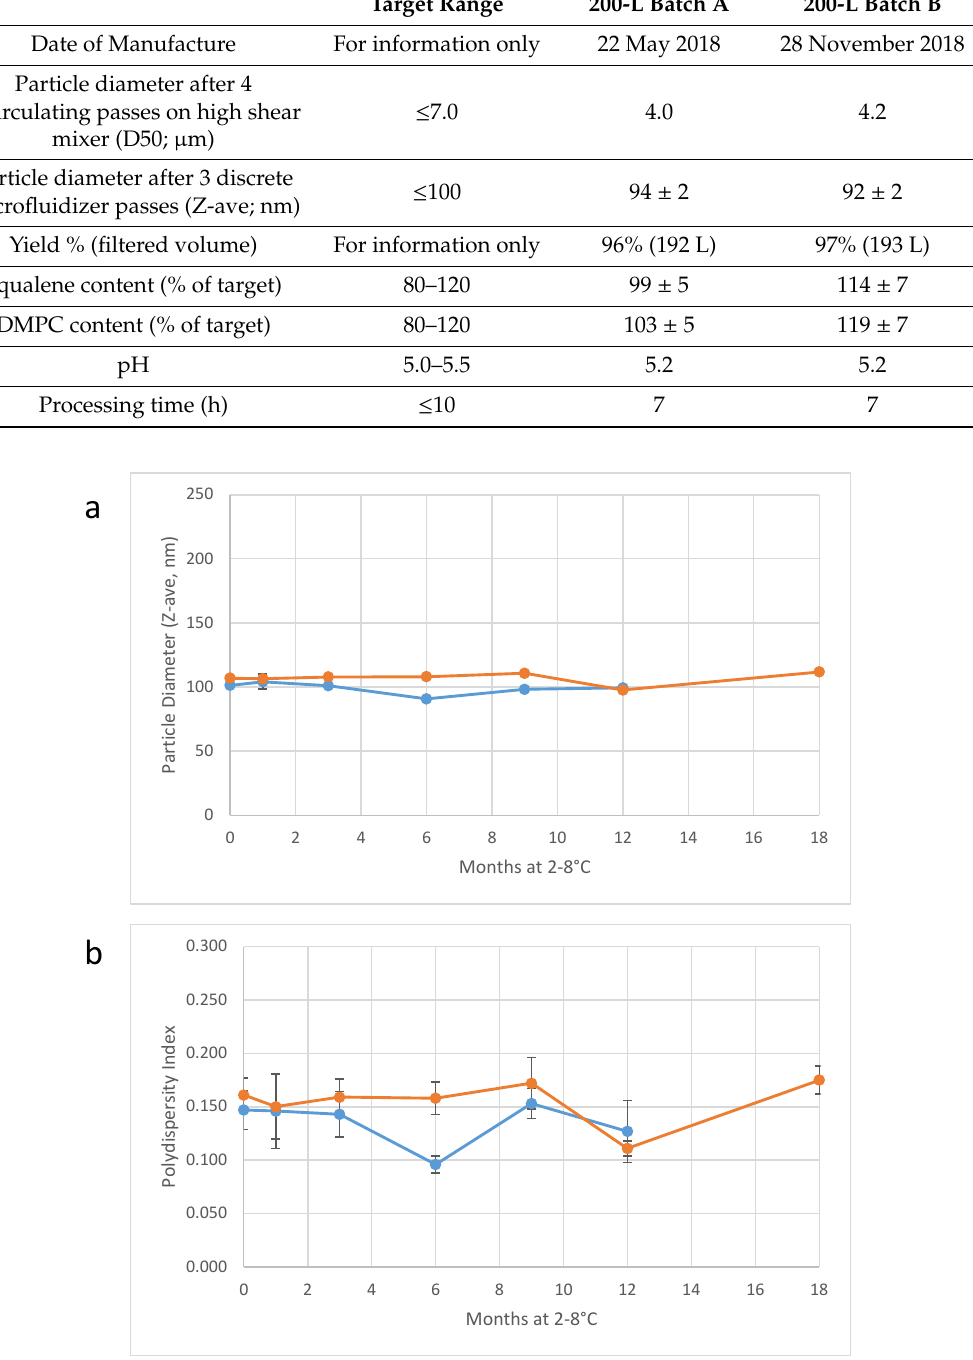
Figure 5. Physical stability of the two large-scale batches from Table 7 when stored at 2–8 °C. Droplet diameter ( a ) and polydispersity index ( b ) remain stable for a minimum of 12–18 months. Error bars represent the standard deviation of 8–9 measurements.